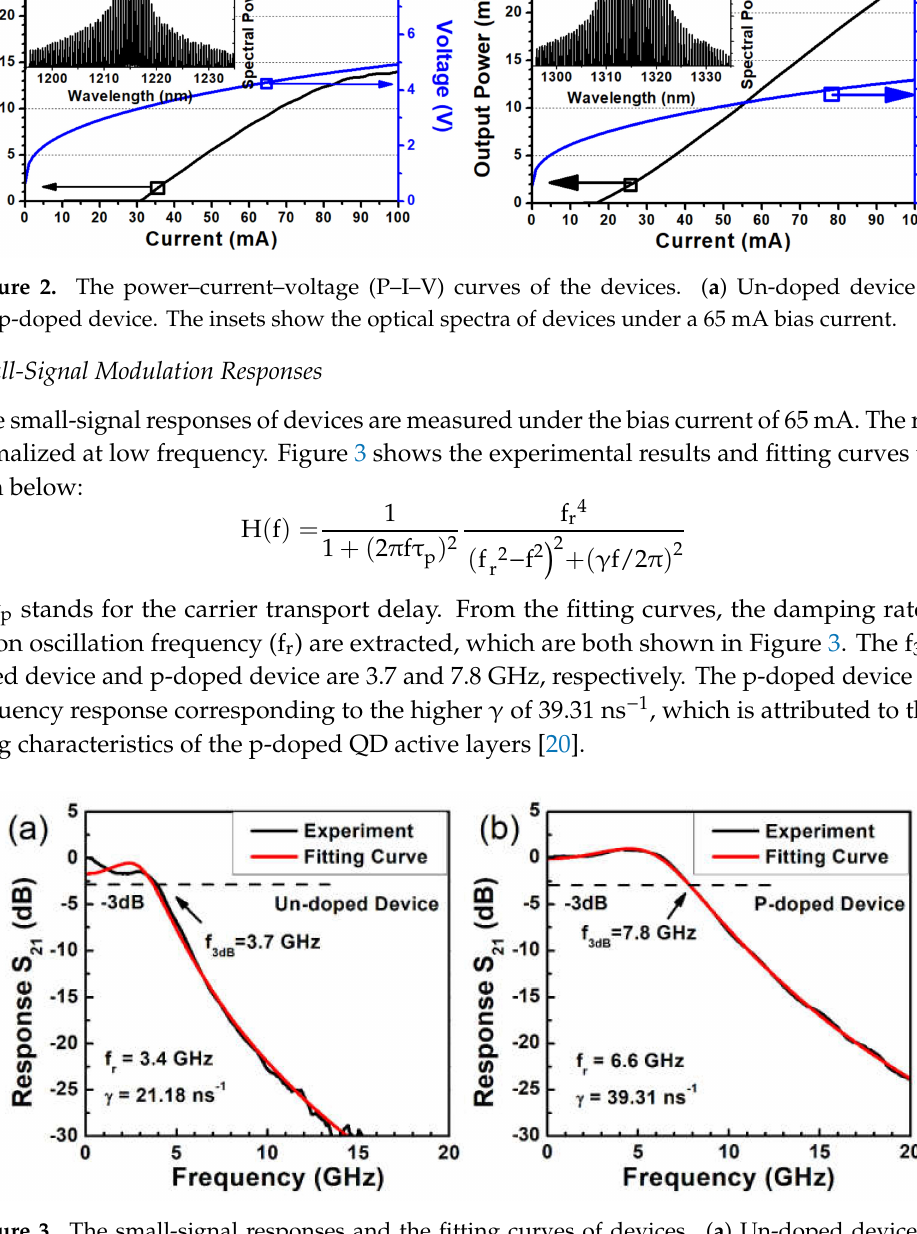
Figure 3. The small-signal responses and the fitting curves of devices. ( a ) Un-doped device and ( b ) p-doped